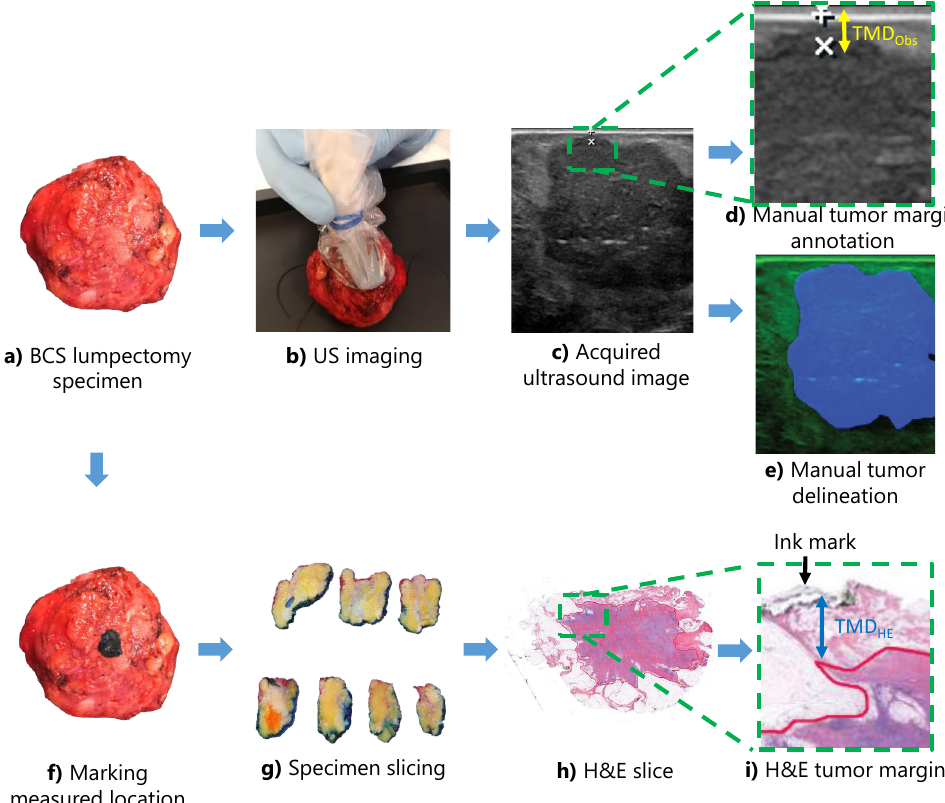
Figure 1. Overview of the method for data acquisition on lumpectomy specimens. An US image ( b , c ) was captured on a tissue location on the lumpectomy specimen ( a ) where the shortest margin ( TMD Obs ) was present ( c ). In this image, the distance was measured and the location of this distance was marked with the ultrasound device annotation tool (white crosses in ( d )). On the actual margin of the specimen, this location was marked with black ink to enable correlation with histopathology ( f ). After data acquisition, the BCS specimen was further processed according to standard protocol, including slicing of the tissue ( g ). The microscopic H&E slices were annotated by a pathologist and the TMD HE was obtained by measuring the minimum TMD from the marked margin region to the tumor in the H&E slice ( h , i ). Additionally, the tumor lesion in the BUS image was manually delineated by two independent observers (blue shade in ( e